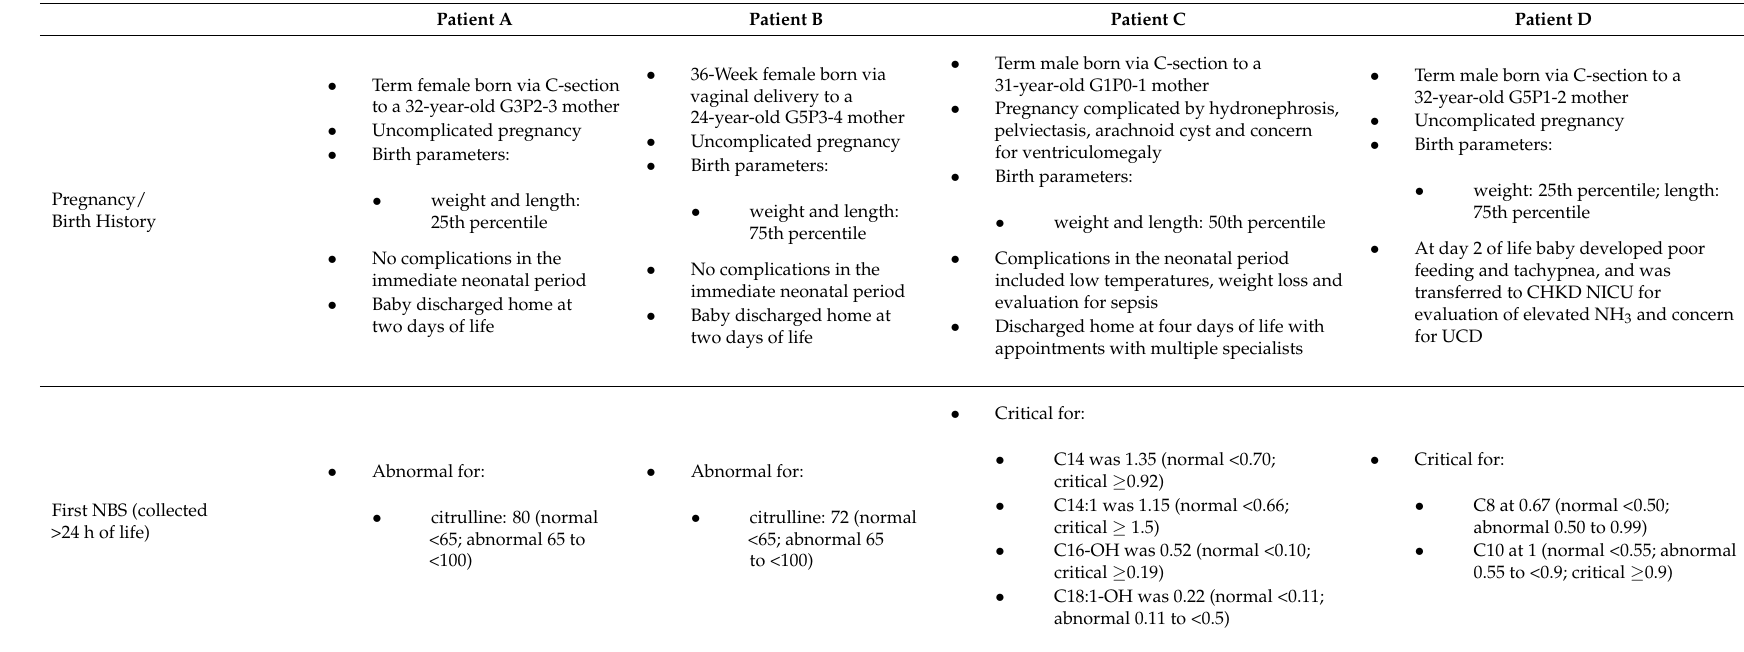
Table 1. Four probands and their newborn screening lab values as well as follow-up